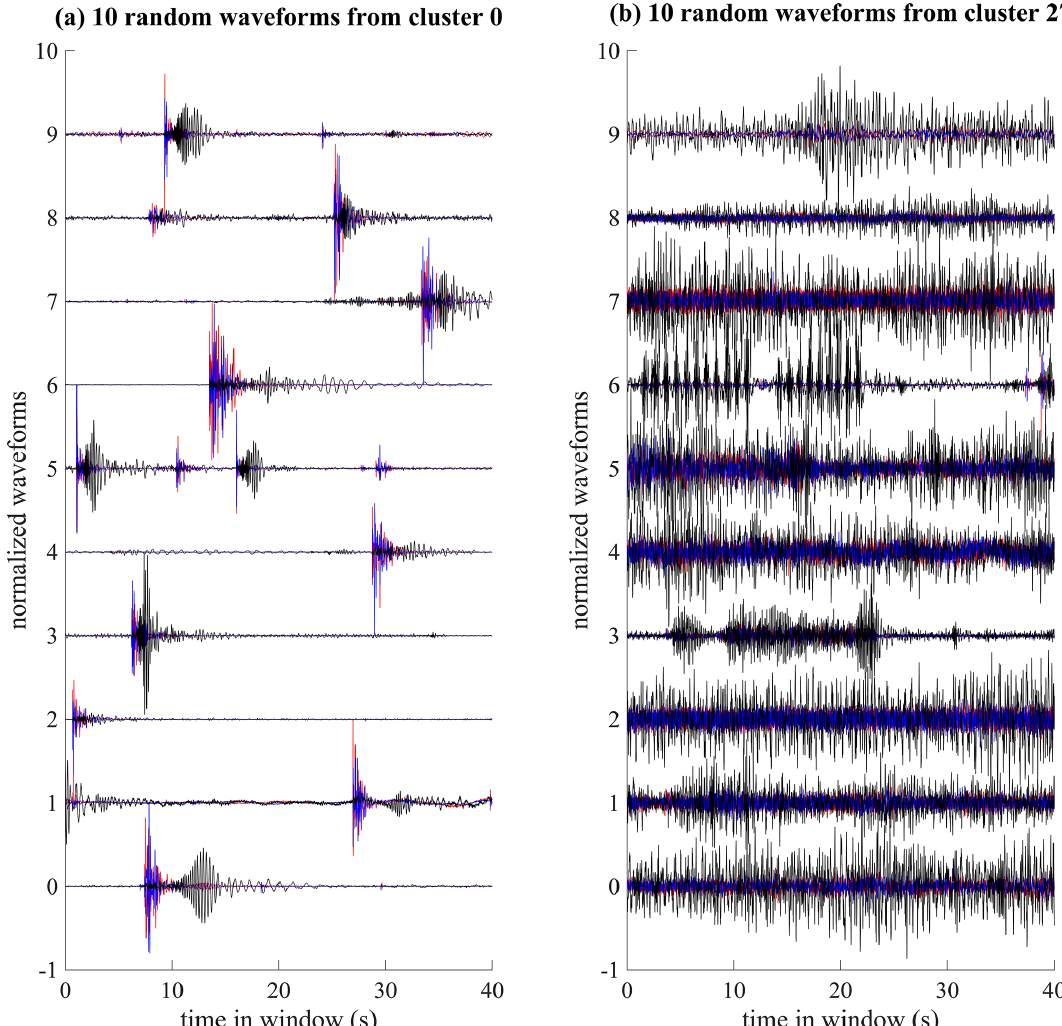
Figure 4. (a) Random waveforms extracted from cluster 0, which contains mainly clean icequakes. (b) Random waveforms extracted from cluster 27, which contains mainly signals from anthropogenic activities. Black: vertical component, blue: axial component, red: transverse component of